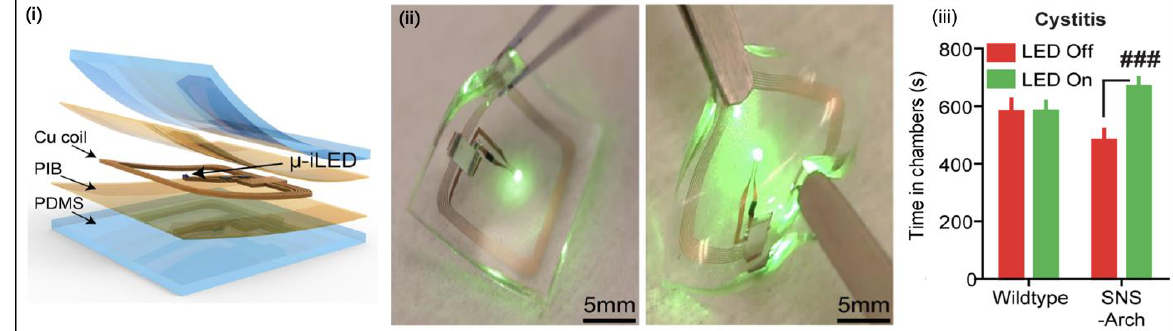
Figure 15. Optoelectrical system for interstitial cystitis. ( i ) Schematic depiction of the layered optoelectronic device, ( ii ) demonstrating the flexibility of the device using forceps, and ( iii ) a graph showing that SNS-Arch mice display a significant response for LED ON compared to LED OFF, whereas wild-type mice have no preference (### p = 0.0065, 11 mice per group, two-way analysis of variance (ANOVA))